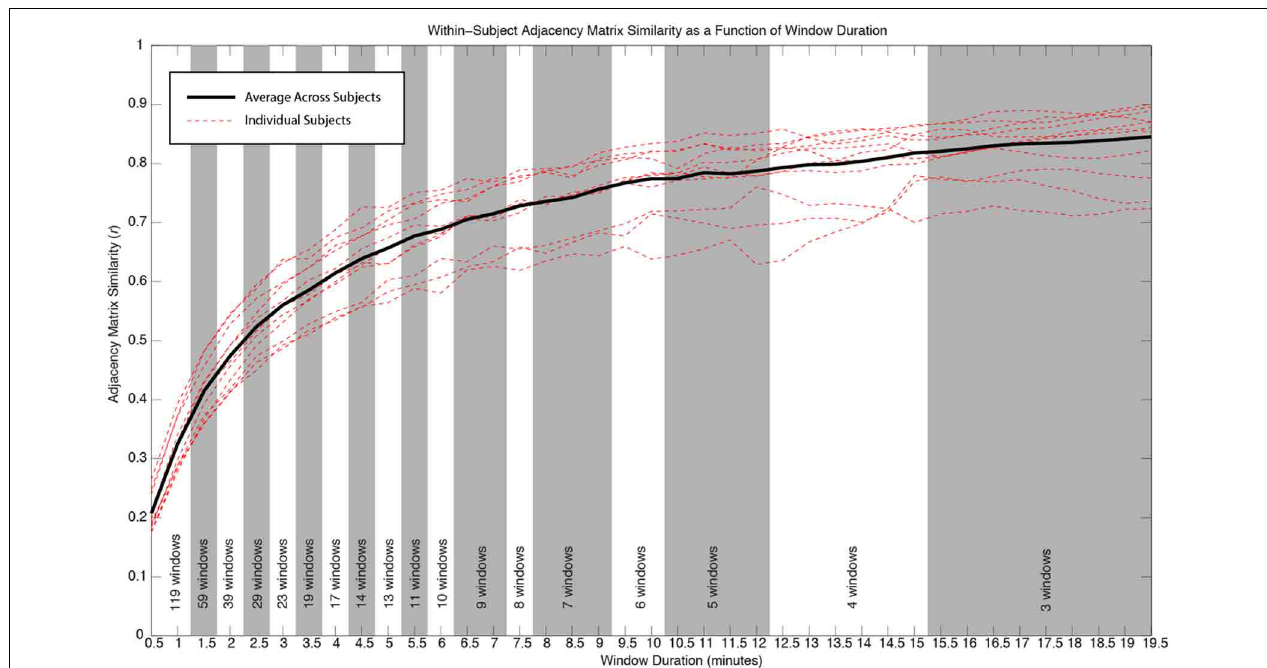
FIGURE 4 | Similarity of whole-brain connectivity vs. window duration. Data for individual subjects are shown as red dashed lines. Average across all subjects is shown in black. The similarity of connectivity matrices clearly decreases as a function of window duration. The decreasing rate is particularly accentuated for durations below 10min. As window duration